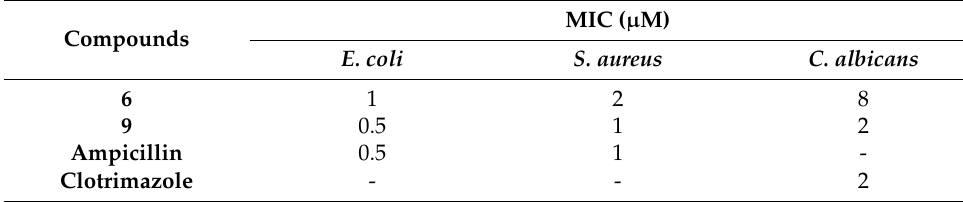
Table 3. The MIC of OSe compounds 6 and 9 .